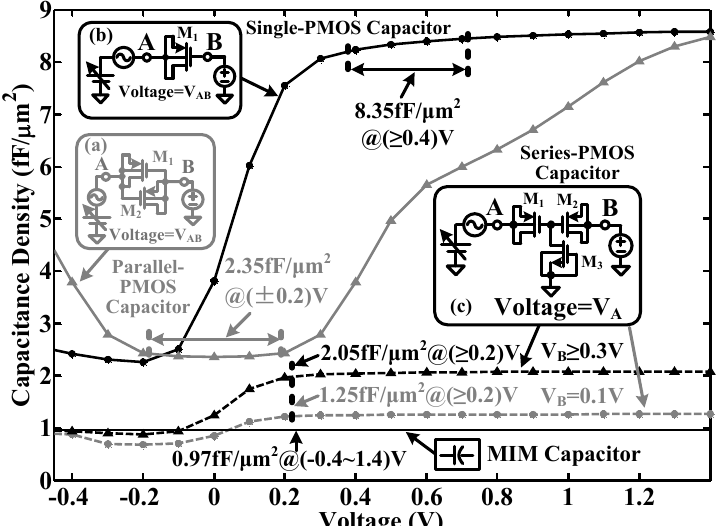
Figure 8. Simulated capacitance-voltage (C-V) curves of the proposed MOS capacitors in a 0.18- µ m CMOS process: ( a ) parallel-PMOS type in the depletion region; ( b ) single-PMOS type and ( c ) series-PMOS type in the accumulation region.